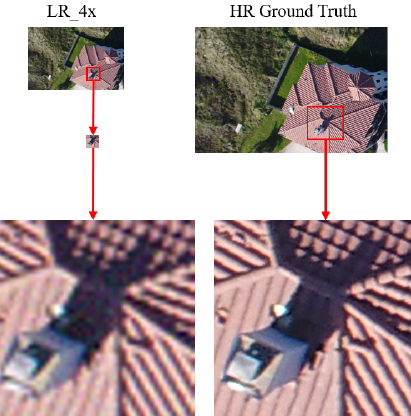
Figure 8. LR and corresponding HR image patches.